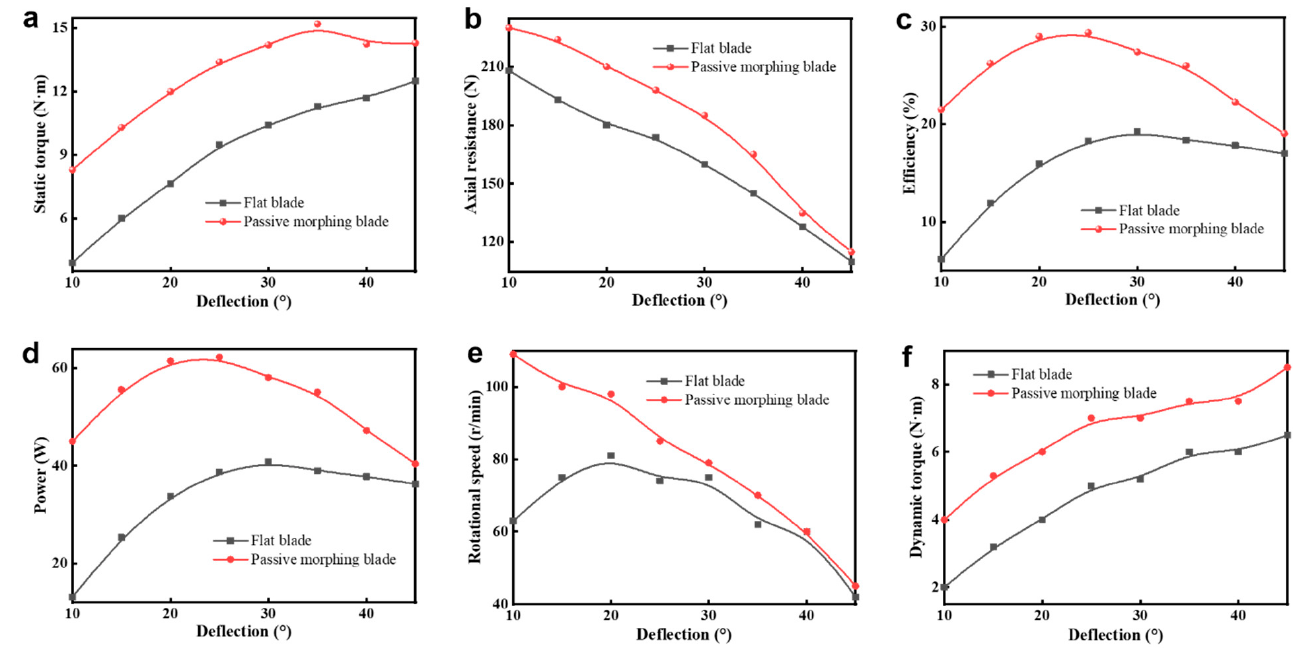
Figure 7. Effect of blades type and deflection angle on PTO: ( a ) static torque; ( b ) axial resistance; ( c ) efficiency; ( d ) dynamic torque; ( e ) power; ( f ) rotational speed.